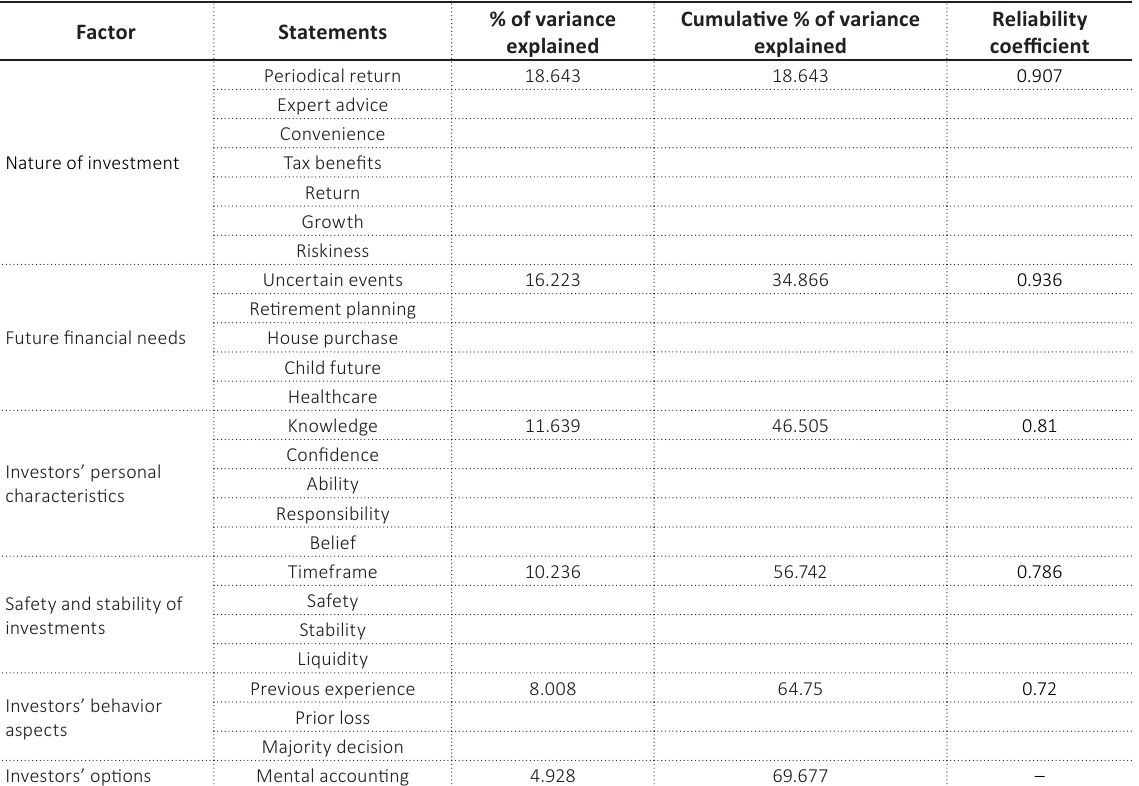
Table 4. Percentage of variance